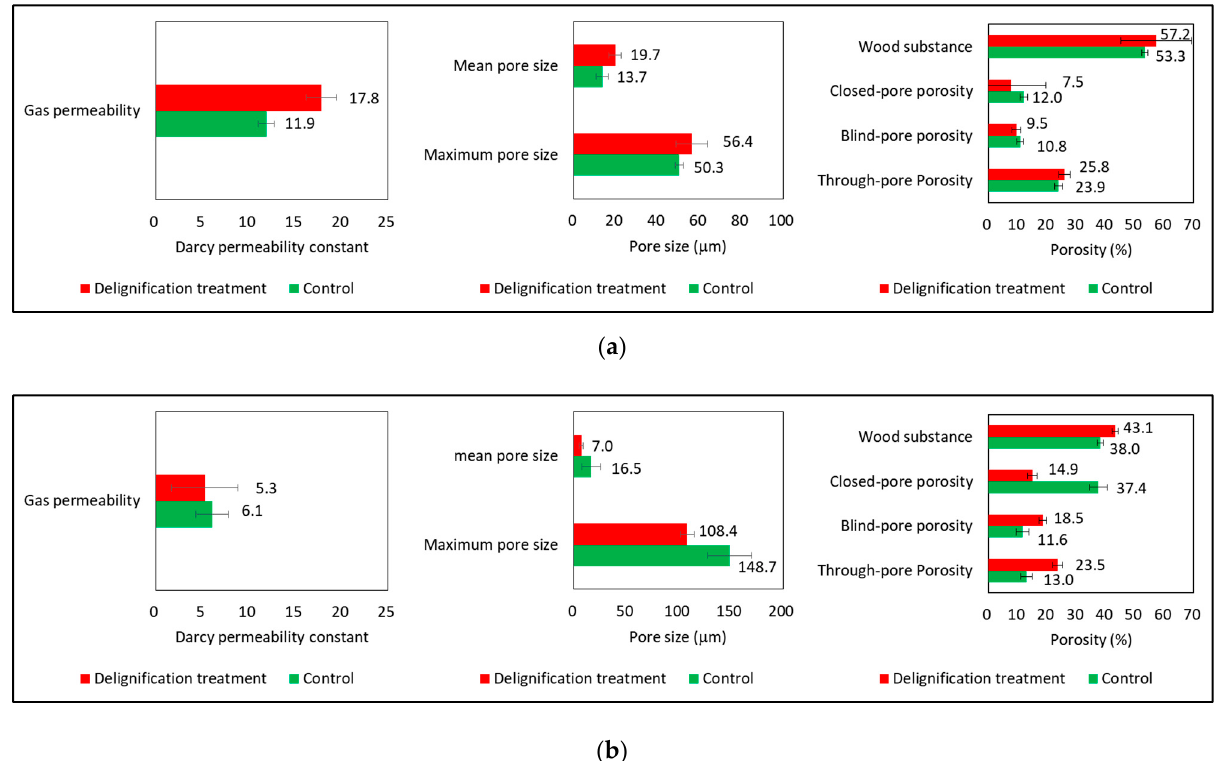
Figure 4. Gas permeability, pore size, and porosity analysis before and after delignification treatment of momala and red toon: ( a ) Momala; ( b ) Red toon.